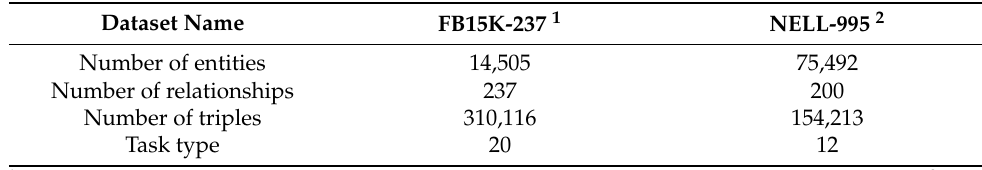
Table 1. Dataset